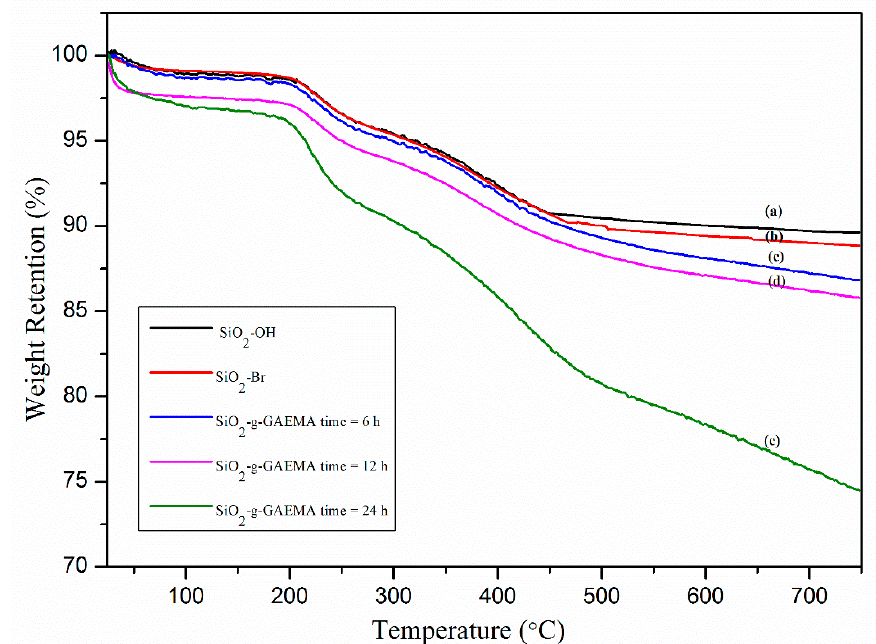
Figure 3 . Thermogravimetric analysis (TGA) curves of (a) bare SiO 2 , (b) SiO 2 -Br, (c) SiO 2 -g-GAEMA (reaction time = 6 h), (d) SiO 2 -g-GAEMA (reaction time = 12 h), and (e) SiO 2 -g-GAEMA (reaction time = 24 h).